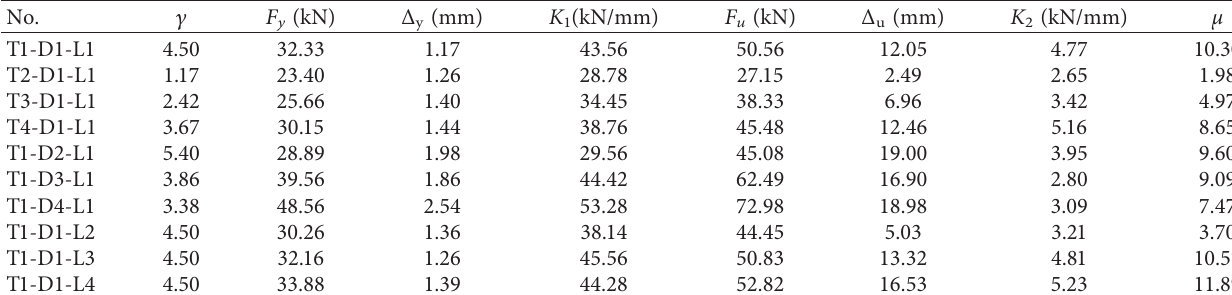
Figure 4: The load-displacement curves of the connections. (a) Dowel diameter. (b) The thickness. (c) End distance. Table 2: The test results of the connections in different groups.